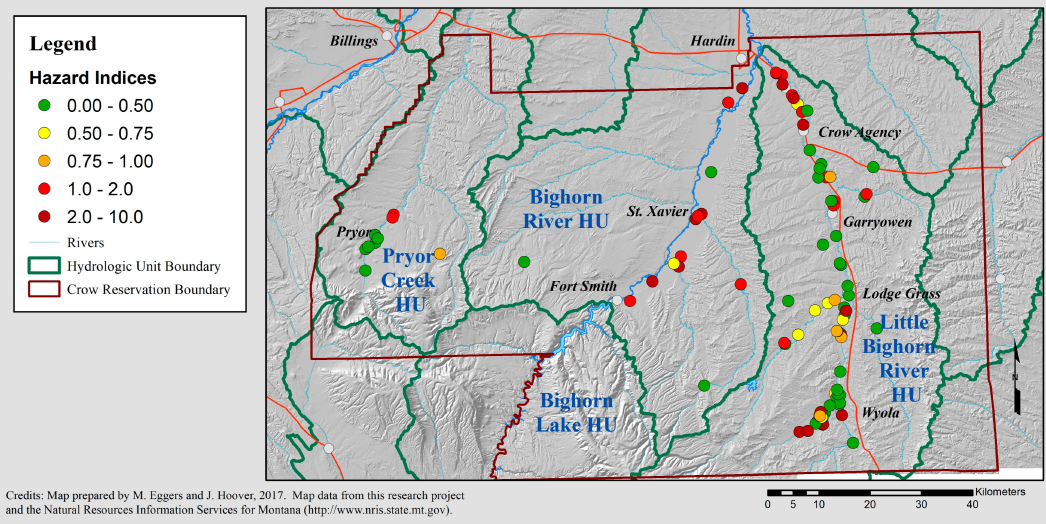
Figure 2. Hazard indices for home wells on the Crow Reservation. Values 1.0 and higher (red and dark red circles) represent wells with water unsafe for lifetime consumption. Town locations, rivers and boundaries provided by States of Montana and Wyoming [151,152].